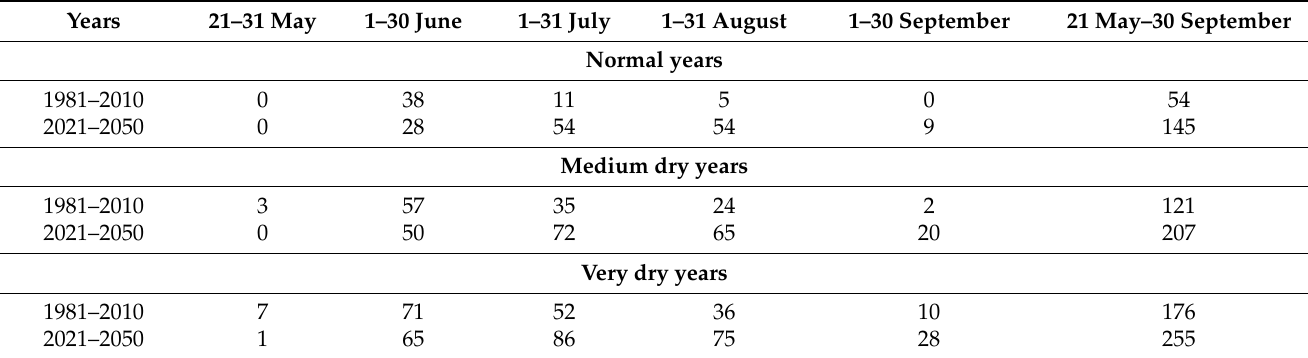
Table 7. Precipitation deficit (mm) in the cultivation of Jerusalem artichoke in the region of Kuyavia